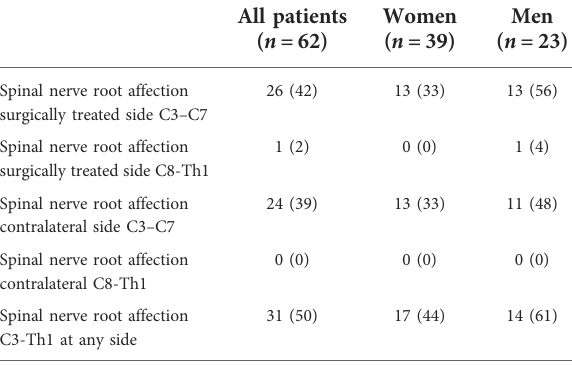
TABLE 4 MRI fi ndings in neck in surgically treated patients with ulnar nerve compression at the elbow. All patients